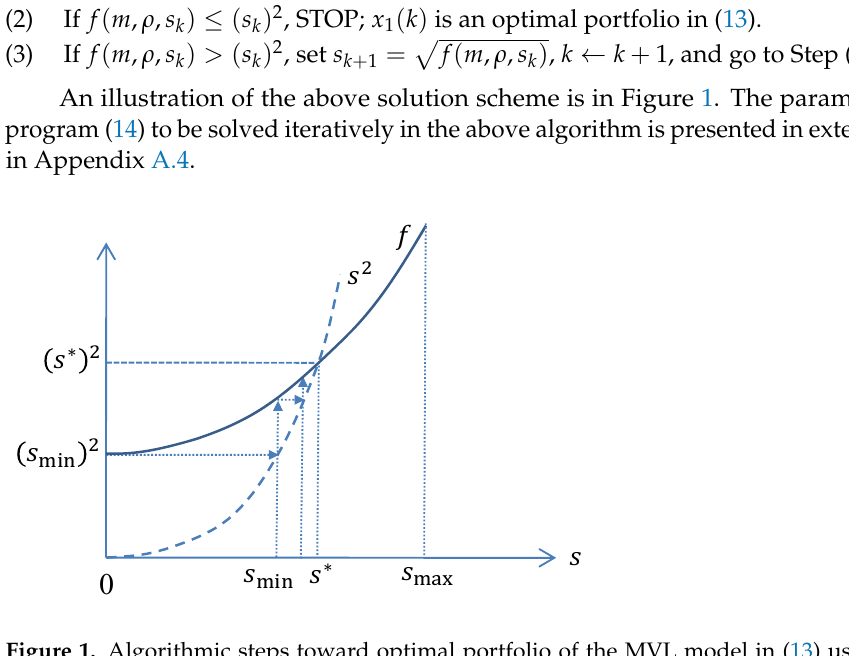
Figure 1. Algorithmic steps toward optimal portfolio of the MVL model in (13) using f defined in